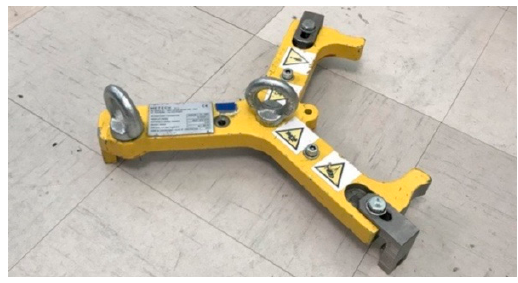
Figure 13. Mounting previously used by Wärtsilä personnel [42].